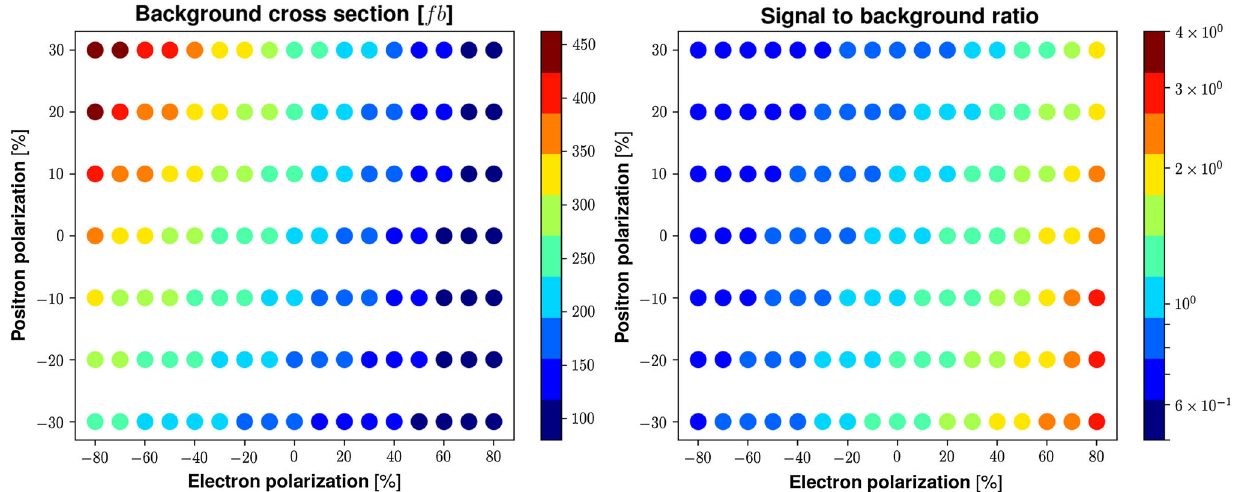
hasbeentakenassignalforillustration.Thesignal-to-backgroundratios have been normalized at ( P e − , P e + ) = ( 0 , 0 )